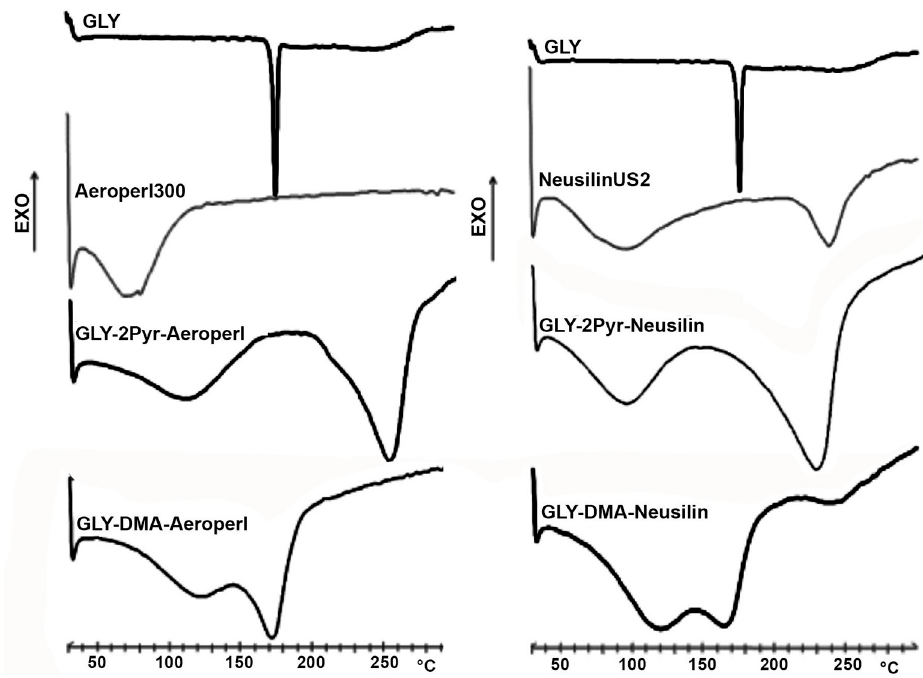
Figure 3. Differential Scanning Calorimetry (DSC) curves of pure glyburide (GLY), Aeroperl ® 300 and Neusilin ® US2 and of the corresponding liquisolid systems with 2-pyrrolidone (2-PYR) or dimetylacetamide (DMA) as non-volatile water miscible solvent.